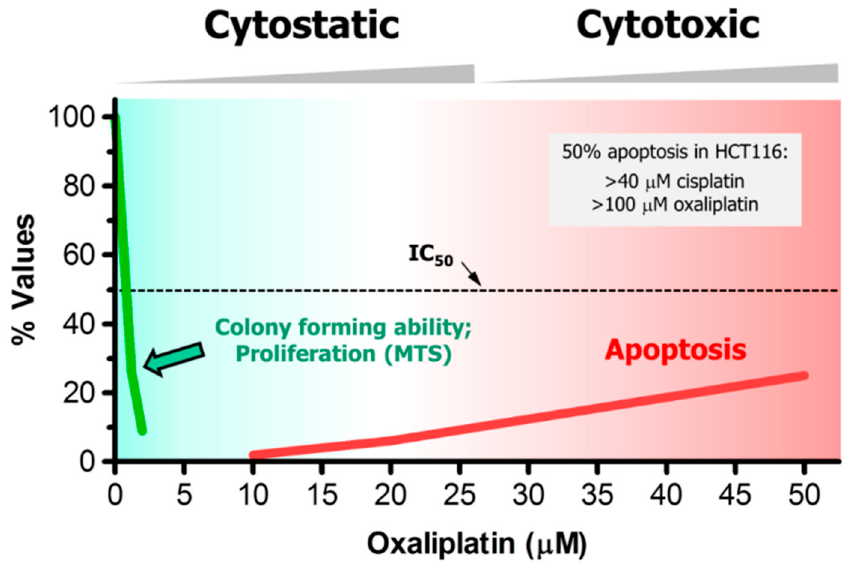
Figure 2. Dose-dependent responses induced by oxaliplatin in HCT116 cells, measured by colony formation [68], cell proliferation (e.g., MTS) and apoptosis assays [67]. Such large discrepancy between growth-inhibitory and apoptosis-inducing concentrations has also been reported for this and other solid tumor-derived cell lines after treatment with cisplatin. In HCT116 cells, for example, <5 µ M [68] and >40 µ M [66] cisplatin concentrations induced 50% effect (IC 50 ) in colony formation and apoptosis assays, respectively.